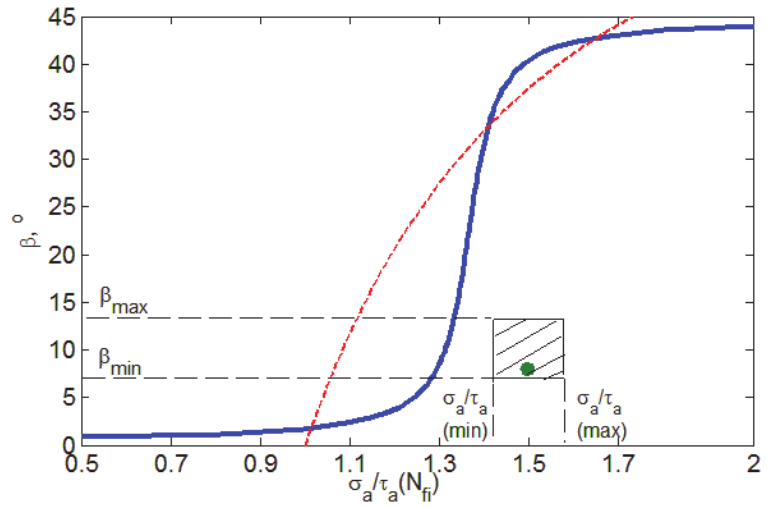
Figure 4: Exemplary analysis of material D30.